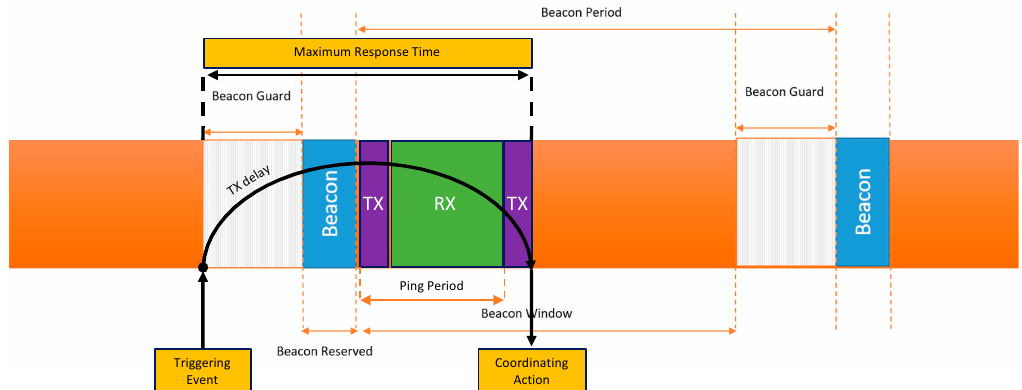
Figure 6. Schematic diagram of the operation times at the LoRaWAN GW corresponding to the scenario used for the computation of the maximum expected time of response between a triggering event and the arrival of the related coordination command.